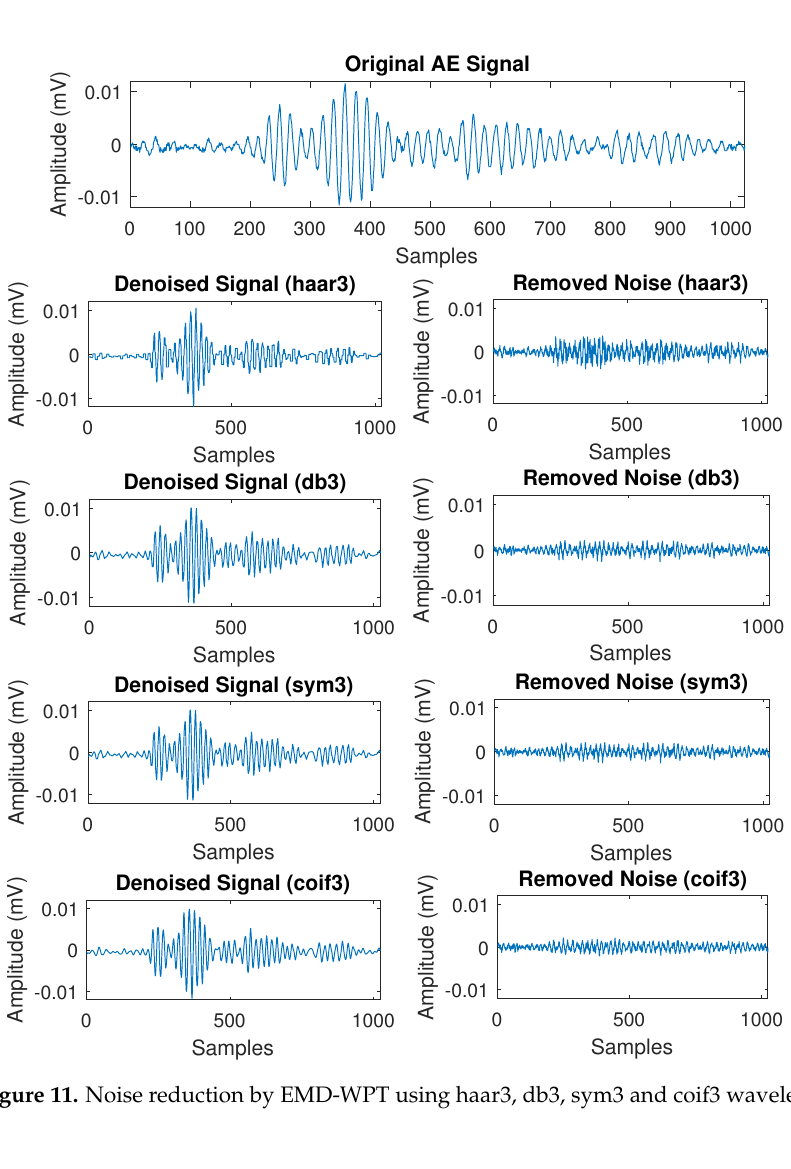
Figure 11. Noise reduction by EMD-WPT using haar3, db3, sym3 and coif3 wavelets.